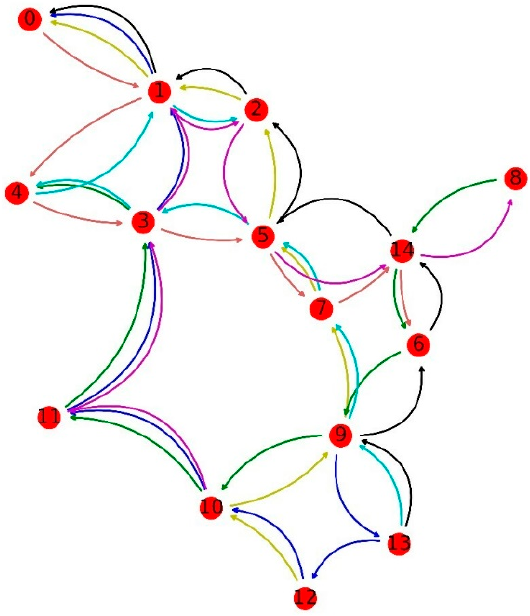
Figure 6. Best network with 7 routes.